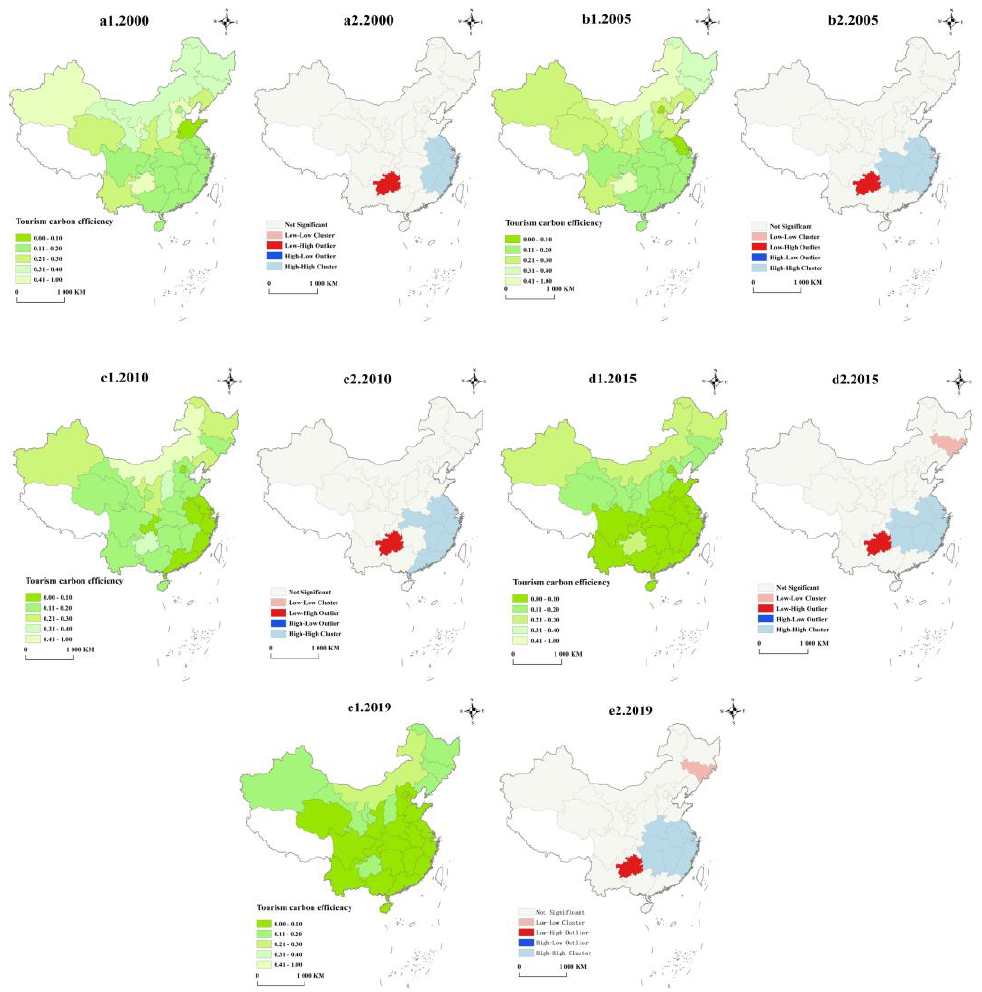
Figure 3. Spatial pattern and LISA cluster of tourism carbon emissions